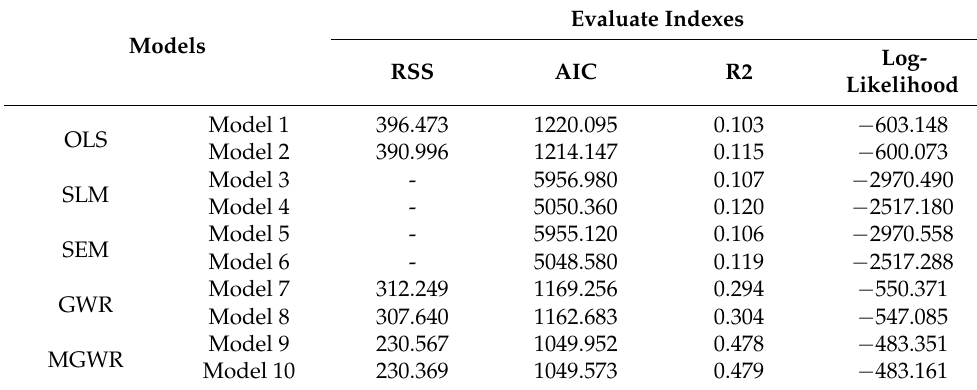
Table 4. The goodness of fit statistics for the 10